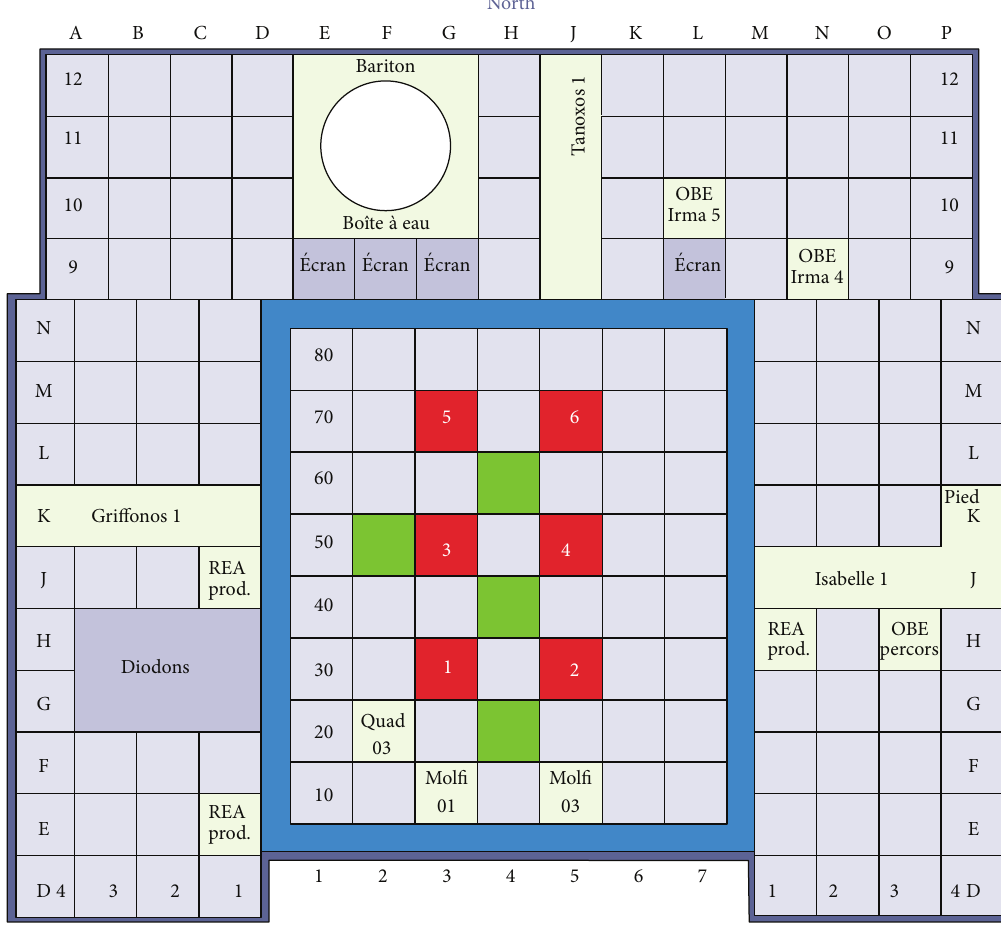
Figure 19: Horizontal cross-section of OSIRIS core [15].